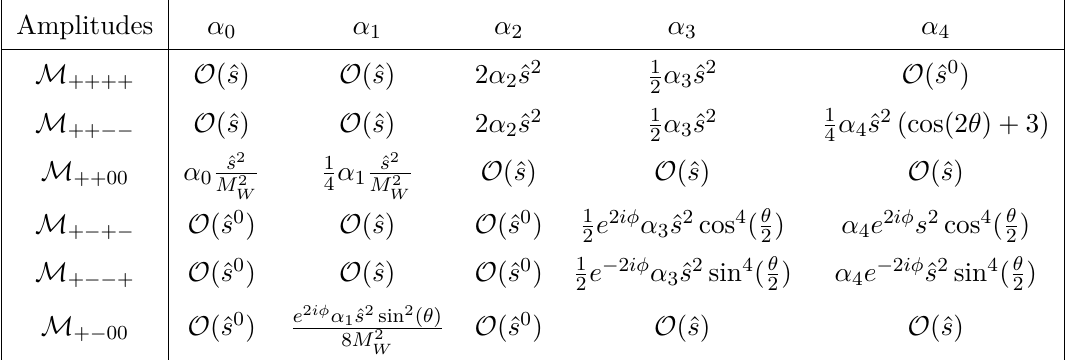
Table 3 . The helicity amplitudes at the order of O ( s 2 )